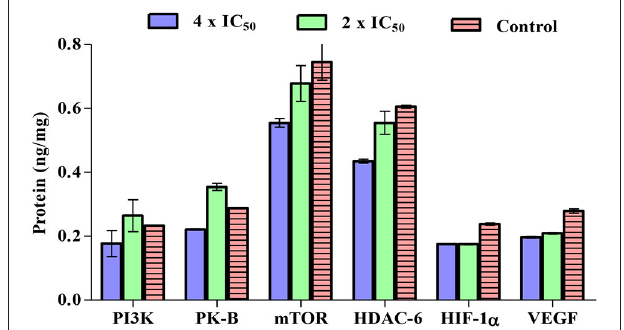
FIGURE 4 | Carvacrol affects the transcriptional level of HYAL and ODC in FaDu cell line. The mRNA expression of the tested gene in treated and non-treated FaDu and K562 cell lines were analyzed using real-time qPCR. Glyceraldehyde 3-phosphate dehydrogenase (GAPDH) was used as an internal control. Data are presented as mean ± SD ( n = 3). Carvacrol potently downregulates the expression of ODC in the FaDu cell line (* p < 0.05, ** p < 0.01).